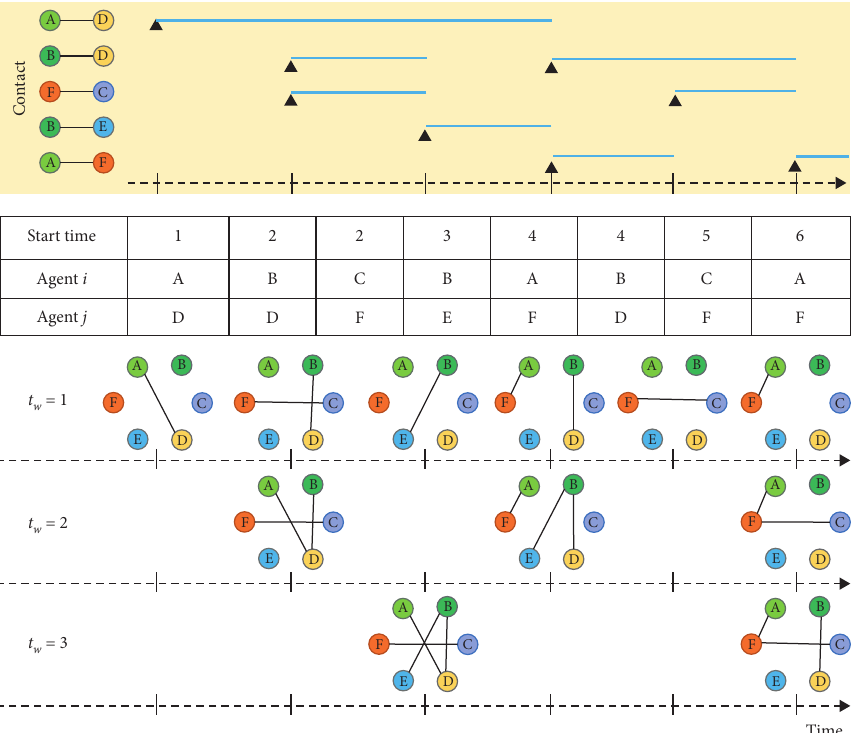
Figure 1: Schematic illustration of the construction of temporal networks and the time slice of a contact sequence, where t time